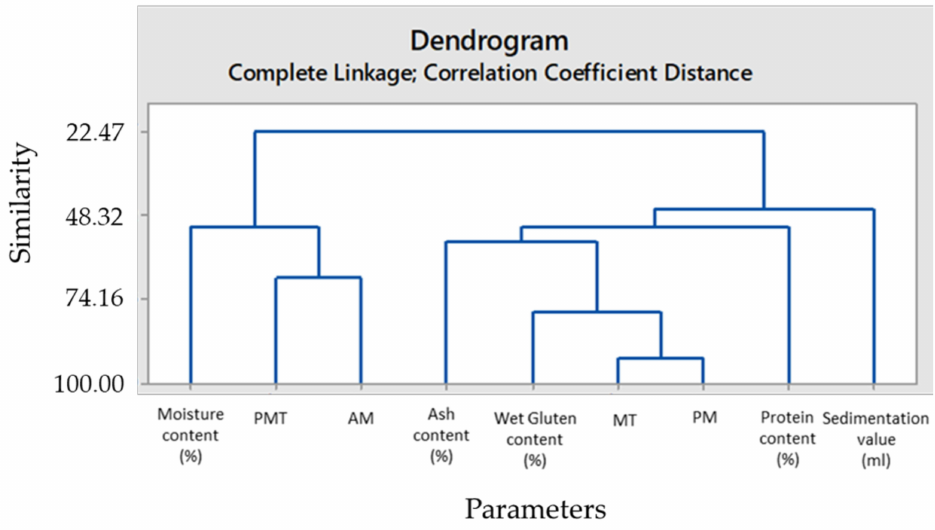
Figure 3. HCA dendogram of conventional gluten quality parameters versus GlutoPeak indices. Table 2. Eigen values of the correlation